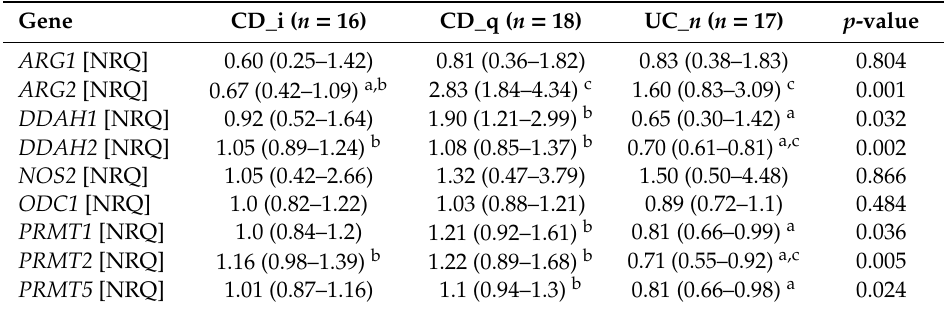
Table 4. L-arginine / NO pathway-associated enzymes in inflamed and quiescent small bowel.